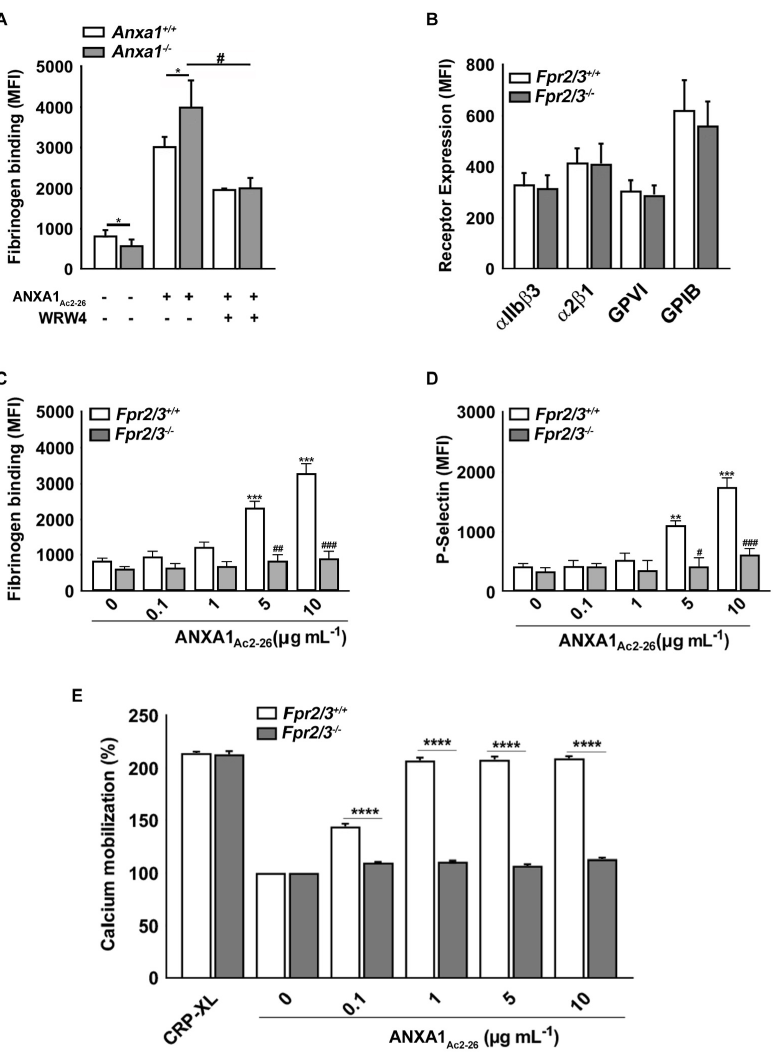
Figure 2. The role of FPR2/ALX in the modulation of ANXA1 Ac2-26 -mediated actions in platelets. ( A ) The amount of fibrinogen binding in platelets obtained from control and Anxa1 − / − mice was quantified by flow cytometry upon treatment with ANXA1 Ac2-26 (10 µ g mL − 1 ) in the presence or absence of WRW4 (5 µ M). ( B ) The expression of major receptors in platelets from control and Fpr2/3 − / − mice was analysed using fluorescently labelled antibodies against specific receptors by flow cytometry. The amounts of fibrinogen binding ( C ) and P-selectin ( D ) were analysed upon activation of platelets obtained from the control and Fpr2/3 − / − mice upon treatment with diverse concentrations of ANXA1 Ac2-26 by flow cytometry. ( E ) Calcium mobilisation in platelets obtained from the control and Fpr2/3 − / − mice was analysed using Fluo-4 AM dye upon stimulation with 10 µ g mL − 1 of CPR-XL or various concentrations of ANXA1 Ac2-26 by spectrofluorimetry. Data represent mean ± S.D. ( n = 4). Statistical analysis was carried out by two-way ANOVA for repeated measures followed by Sidak’s multiple comparisons test for ( A , B ) and the two-way ANOVA test followed by Bonferroni’s multiple comparisons test for ( C – E ). * p < 0.05, ** p < 0.01, *** p < 0.001 and **** p < 0.0001 (same applies to # symbol); ‘*’ and ‘#’ represent the comparison between the treated and untreated samples in the relevant mice group in panels ( C , D